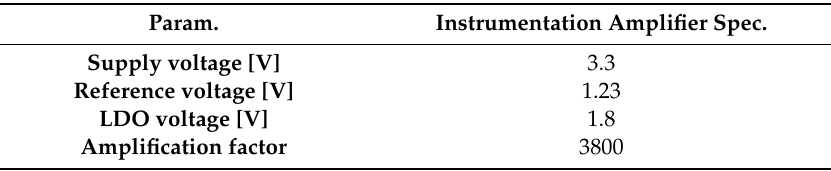
Table 1. Design specifications of the